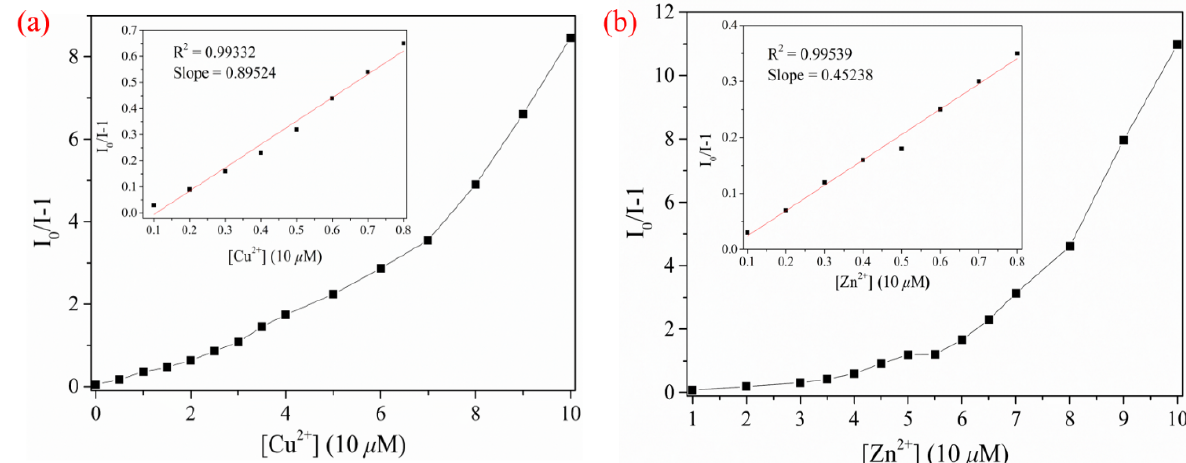
Figure 6. Stern–Volmer diagram of the interaction of sensors CPBI 2 , with Cu 2+ ( a ) and Zn 2+ ( b ) (the illustration shows the Stern–Volmer linear diagram at low concentrations).